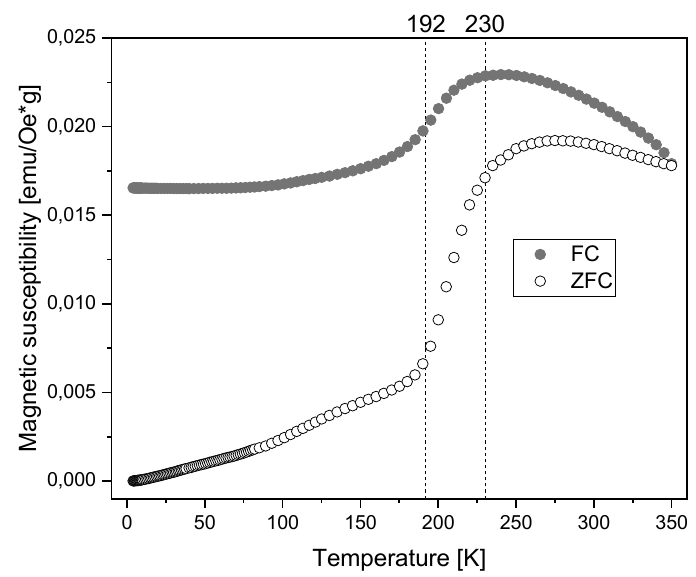
Figure 5. Magnetic susceptibility of MNPs as a function of temperature under 50 Oe magnetic field.